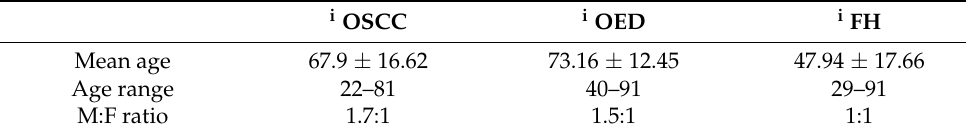
Table 1. Demographic details of the study groups.